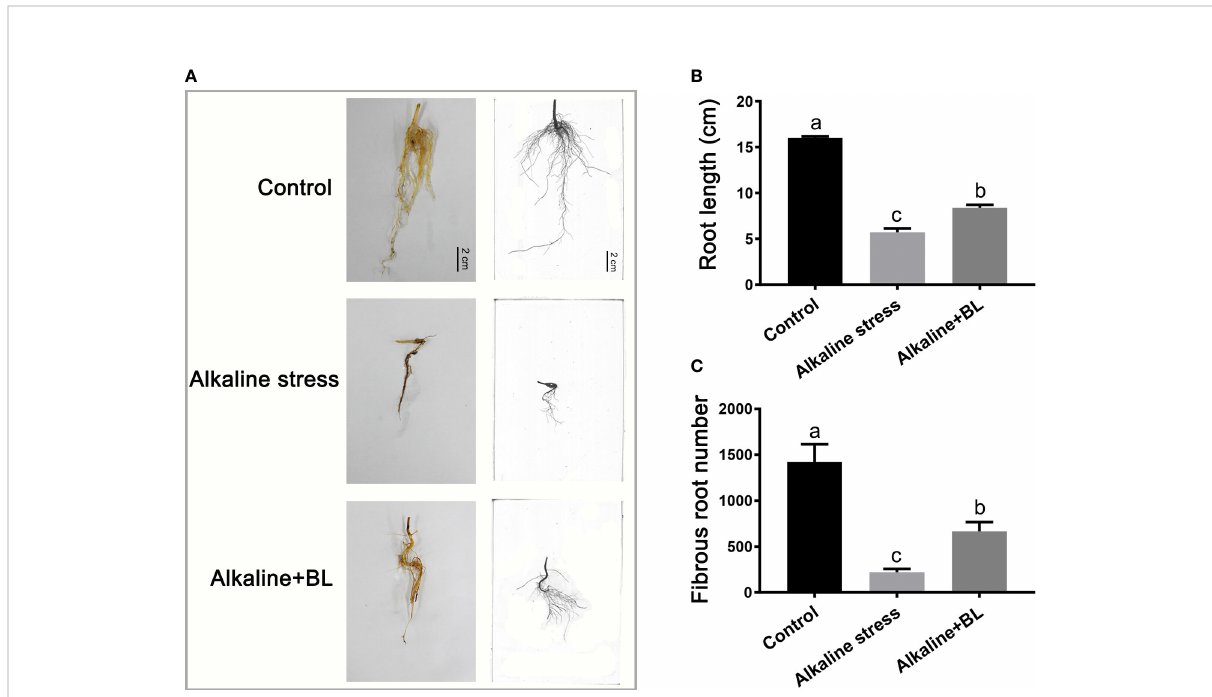
FIGURE 3 The underground phenotypes of M. hupehensis seedlings treated with alkaline stress and exogenous BL. (A) The roots phenotypes of the seedlings treated with alkaline stress and BL at day 15. The scale bar represents 2.0 cm. Effects of exogenous BL on root length (B) and fi brous root number (C) of the seedlings after alkaline stress for 15 days. The data represent the mean ± SD of three biological replicates. Different lowercase letters indicate signi fi cant differences according to Fisher ’ s least signi fi cant difference ( P <